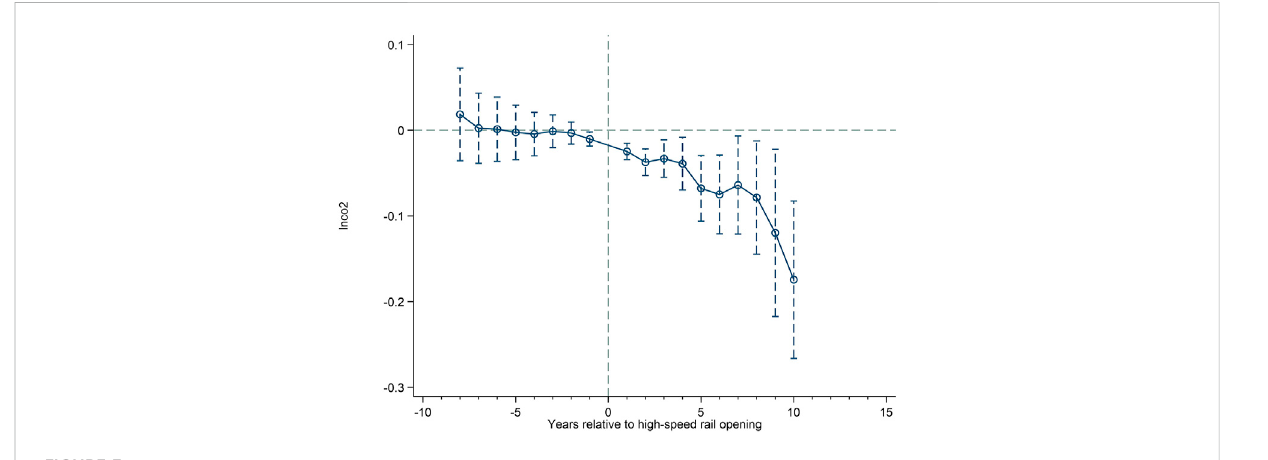
FIGURE 3 The dynamic effect of HSR operation on carbon emission.